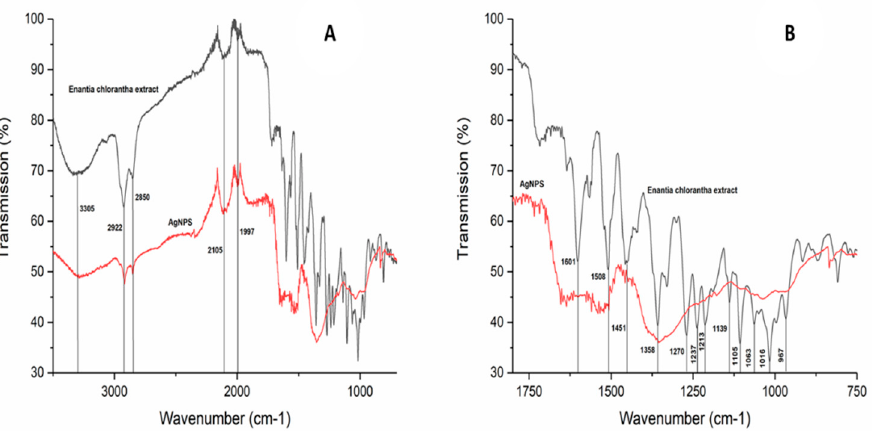
Figure 4. FTIR spectra of the Enantia chlorantha bark extract (black) and green-synthetized silver nanoparticles t (red) in the range from 3500 to 700 cm − 1 ( A ) and 1750 to 750 cm − 1 ( B ).